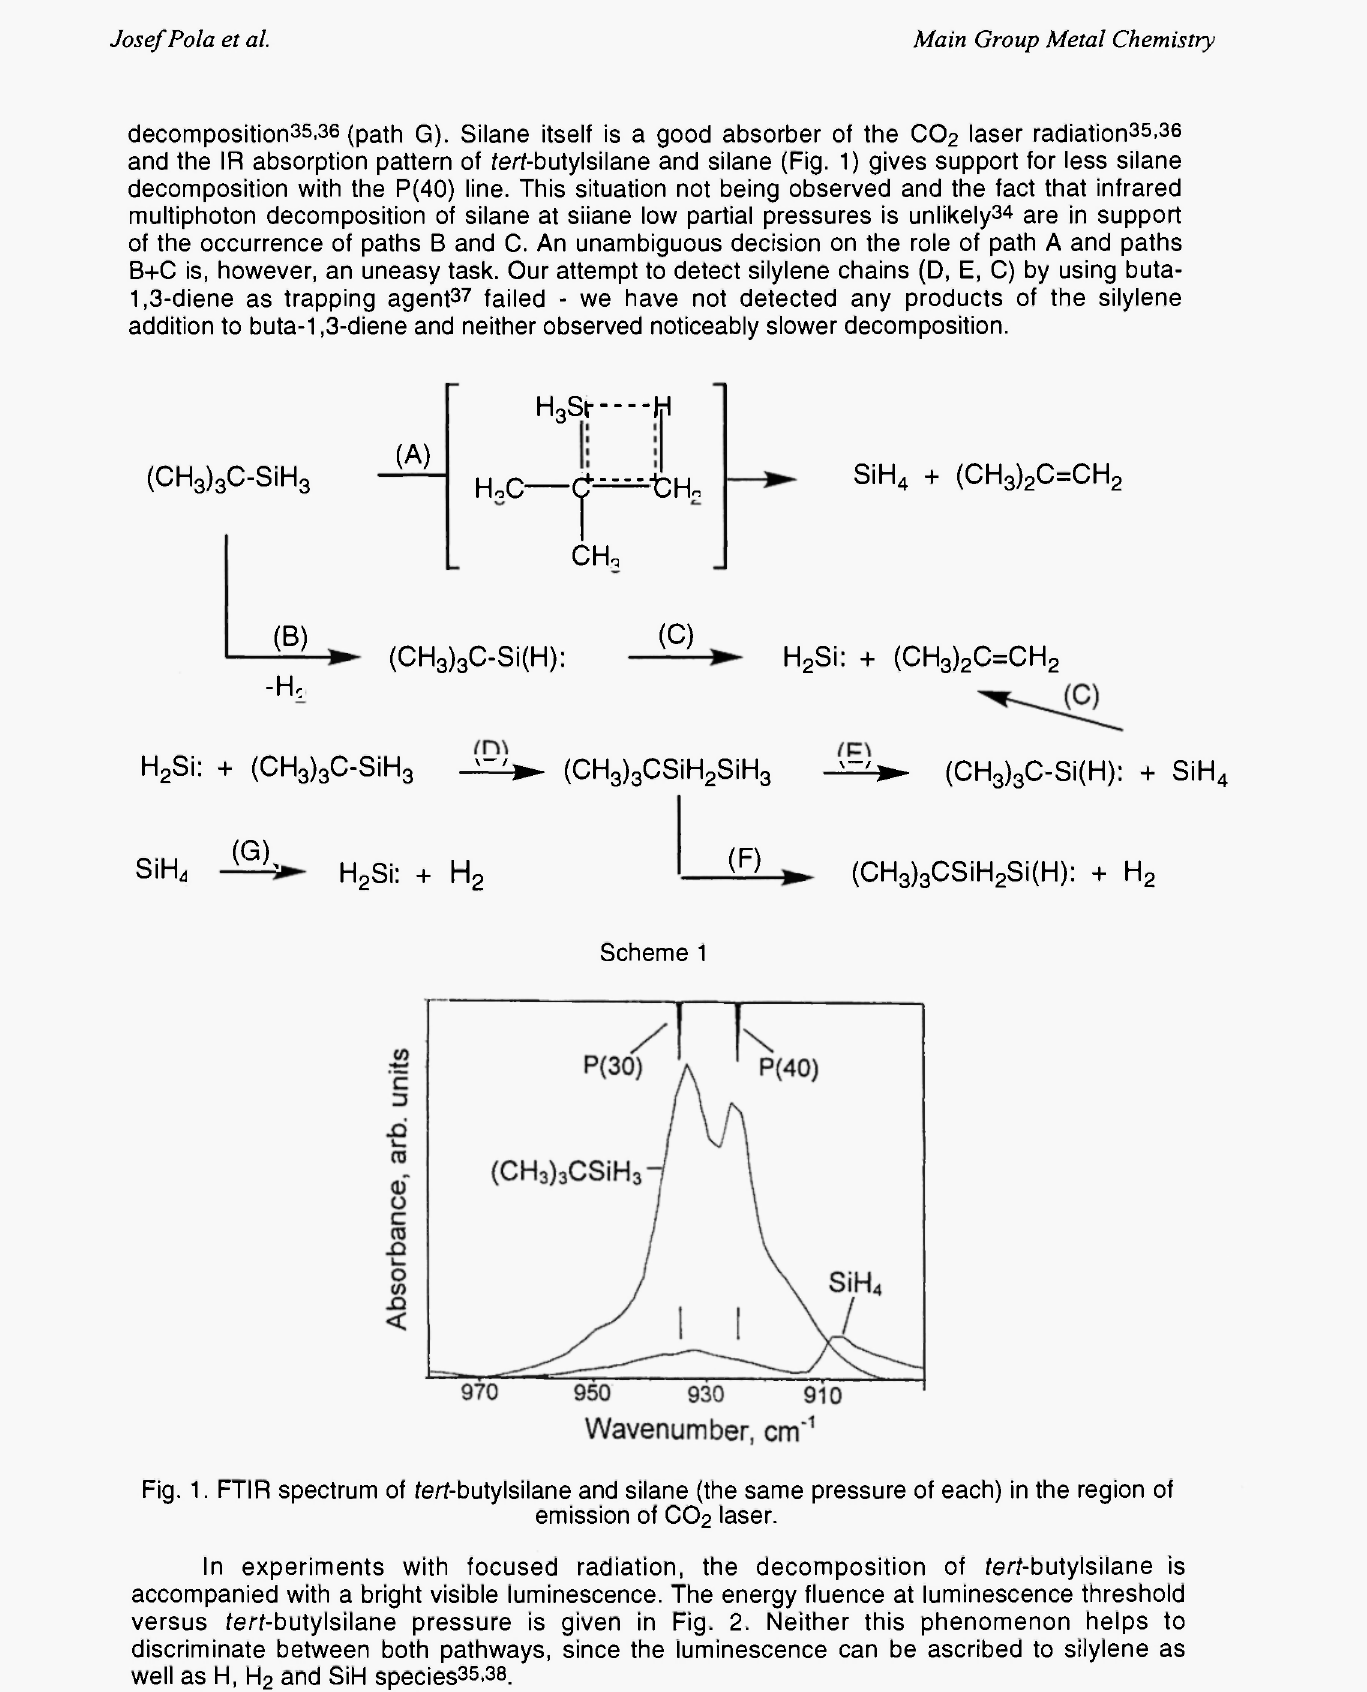
Fig. 1. FTIR spectrum of fert-butylsilane and siiane (the same pressure of each) in the region of emission of C0 2